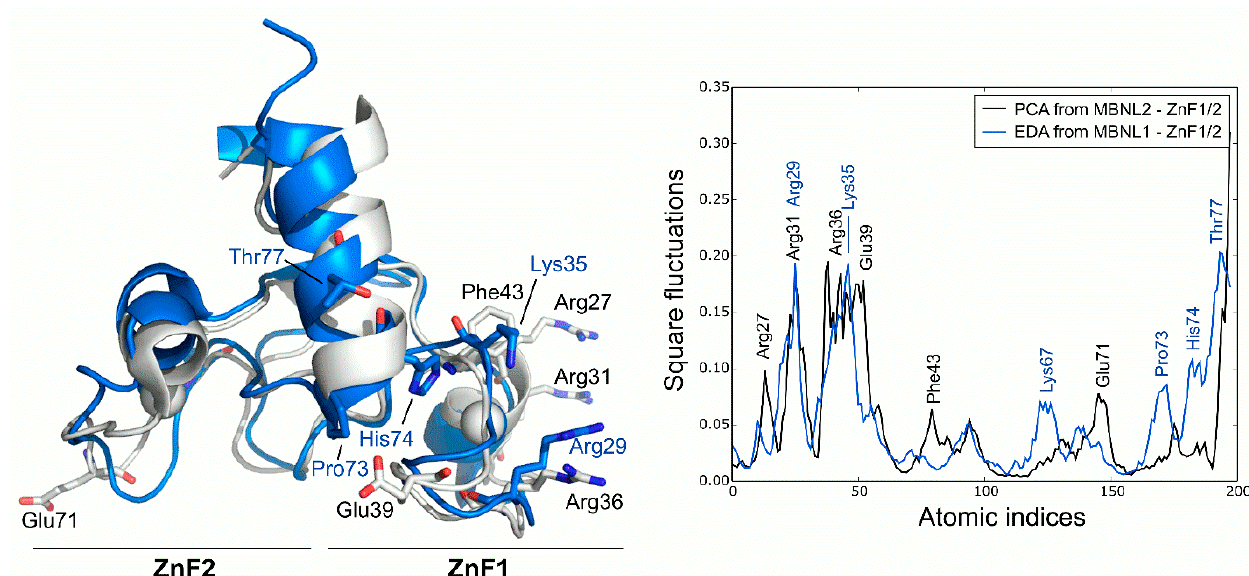
Figure 3. Global fluctuations of MBNL2 and MBNL1 ZnF1/2 computed from their backbone heavy atoms. Atomic indices correspond to residues 24 to 75 for MBNL1 (blue structure) and 26 to 77 for MBNL2 (white structure).